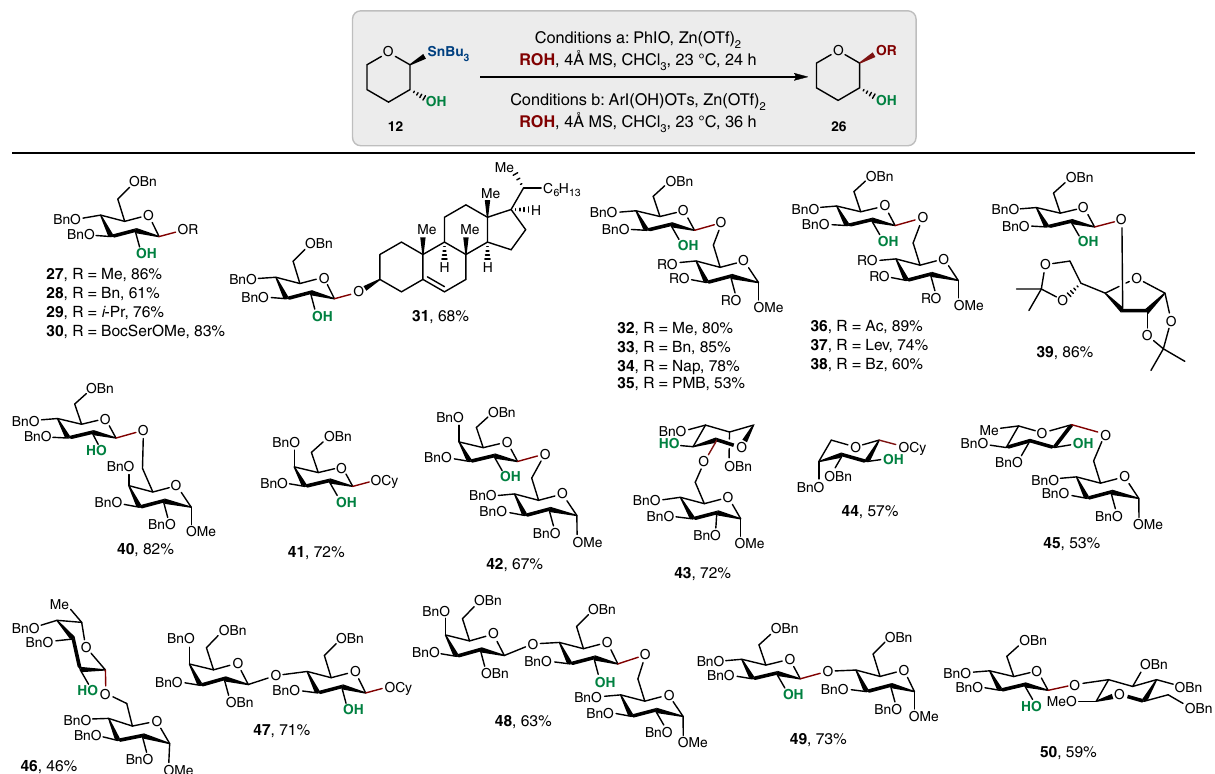
Fig. 3 Scope of oxidative glycosylation with anomeric stannanes. In all cases, only the formation of 1,2- trans anomer was observed (based on the 1 H NMR analysis of the unpuri fi ed reaction mixtures). Conditions a : compounds 27 – 31 , 41 , and 44 and 47 . Conditions b : compounds 32 – 39 , 40 , 42, 43, 45, 46, 48 using PhI(OH)OTs and compounds 49 and 50 using 3,5-(CF 3 ) 2 C 6 H 3 I(OH)OTs. Compound 39 required the addition of 2,4,6-tri -tert